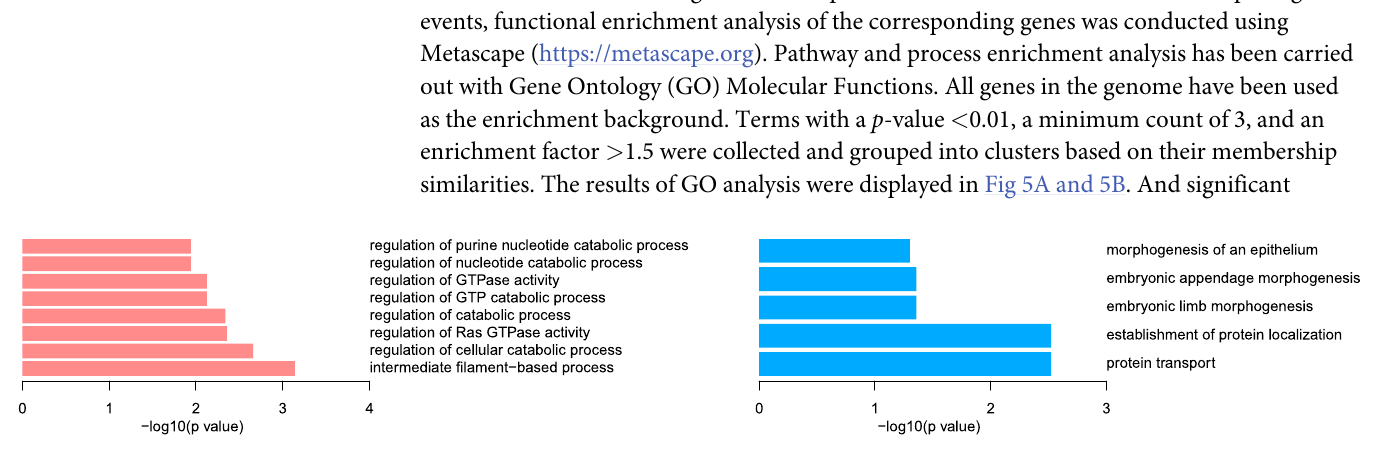
PLOS Computational Biology | https://doi.org/10.1371/journal.pcbi.1010939 March 17,